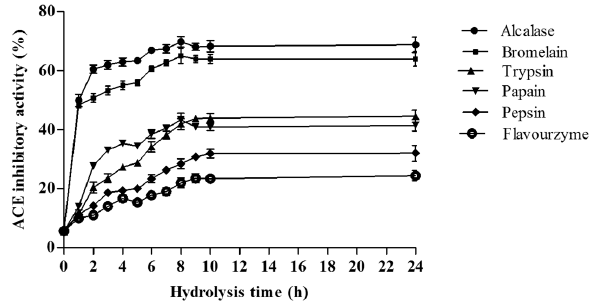
Figure 1. ACE inhibitory activities (%) of A. lecanora hydrolysates as affected by hydrolysis time using enzymatic digestion during 24 h. Sample concentration for this assay was 10.0 mg dry weight/mL. Results represent the mean ± SD of three replications.